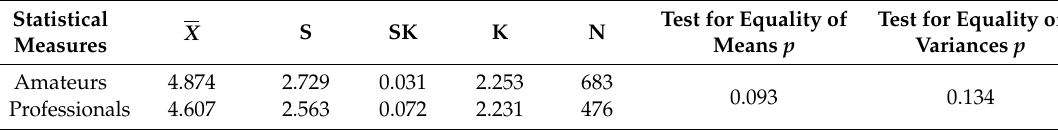
Table 5. Statistical characteristics of the availability of sports and recreation facilities for the residents of the city of Poznan, in the opinion of service